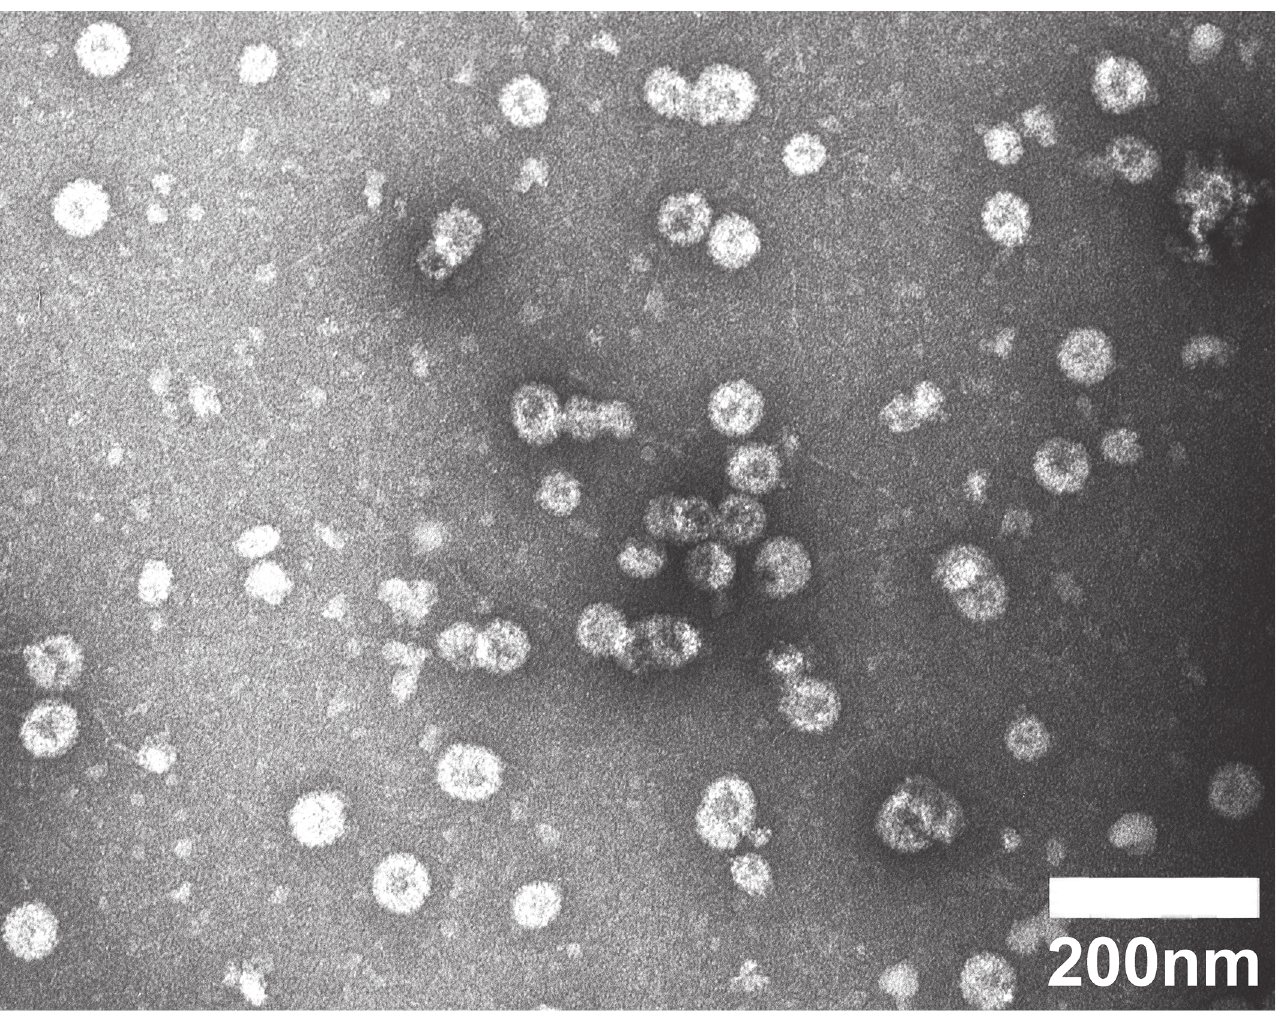
Fig 2. Transmission electron microscopy of chimeric HPV18L1 – 45RG1 VLP. VLP were gradient-purified, negatively stained and visualized at 30,000- fold magnification using a JEOL 1010 electron microscope. The size of the bar indicates 200nm.